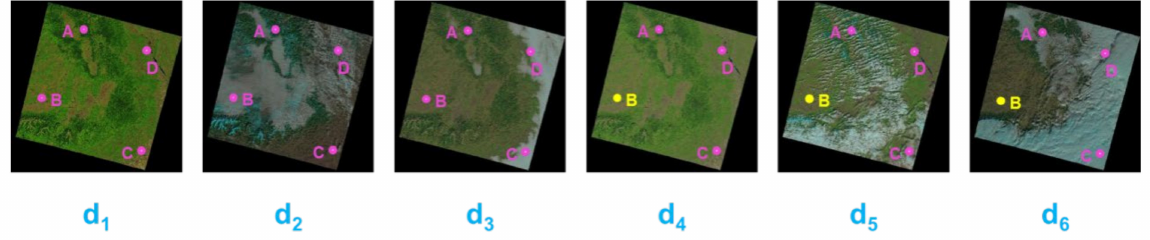
Figure 2. Schematic of sample collection process of SSE